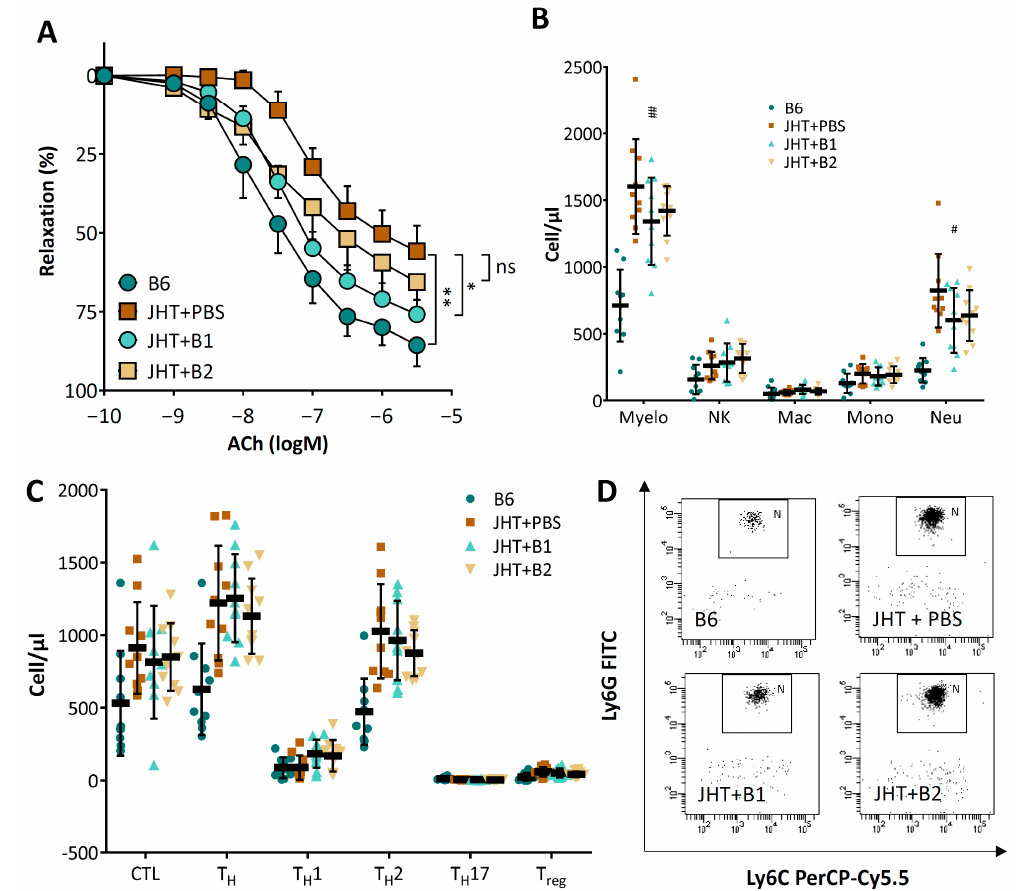
Figure 6. Adoptive B cell transfer improves vascular function in JHT mice. Eight-week-old JHT mice received 5 × 10 6 B-1 or B-2 cells isolated from wild-type mice. Control JHT mice received the same volume of PBS. Two weeks after the adoptive B cell transfer, aortae were isolated for vascular function studies ( A ) and blood for immune cell profiling by FACS analyses ( B – D ). Symbols in panel A represent mean ± SEM; n = 8. The horizontal lines in the scatter dot plots in panels B and C represent mean ± SD. * p < 0.05, ** p < 0.01, compared with B6 mice; # p < 0.05, ## p < 0.01, compared with JHT+PBS mice; two-way ANOVA.